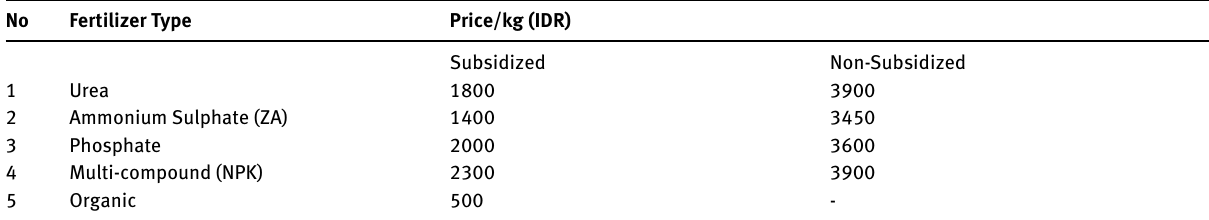
Table 4: Price of Main Fertilizer in Indonesia No Fertilizer